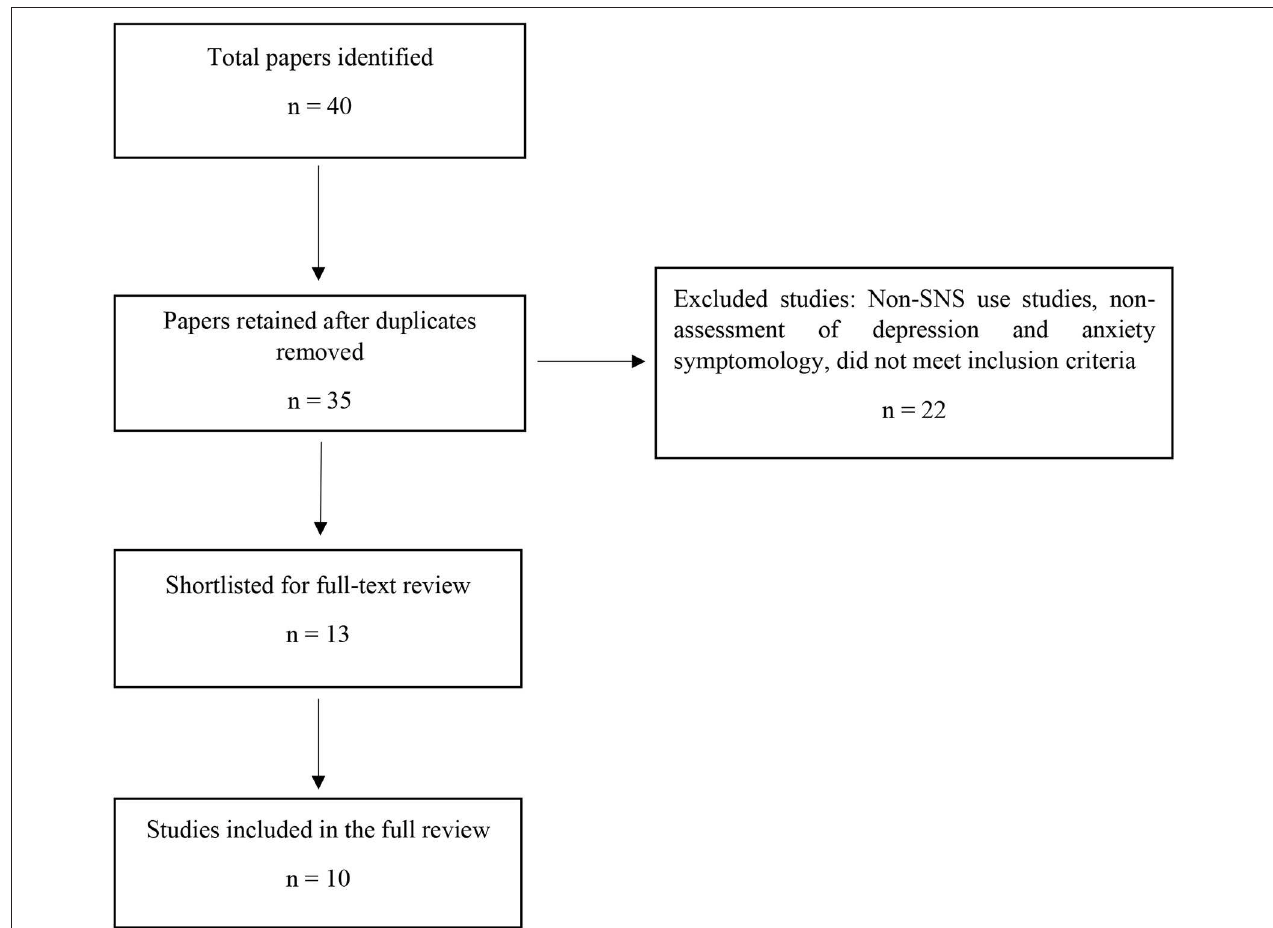
FIGURE 1 | Flow diagram of the study selection process.